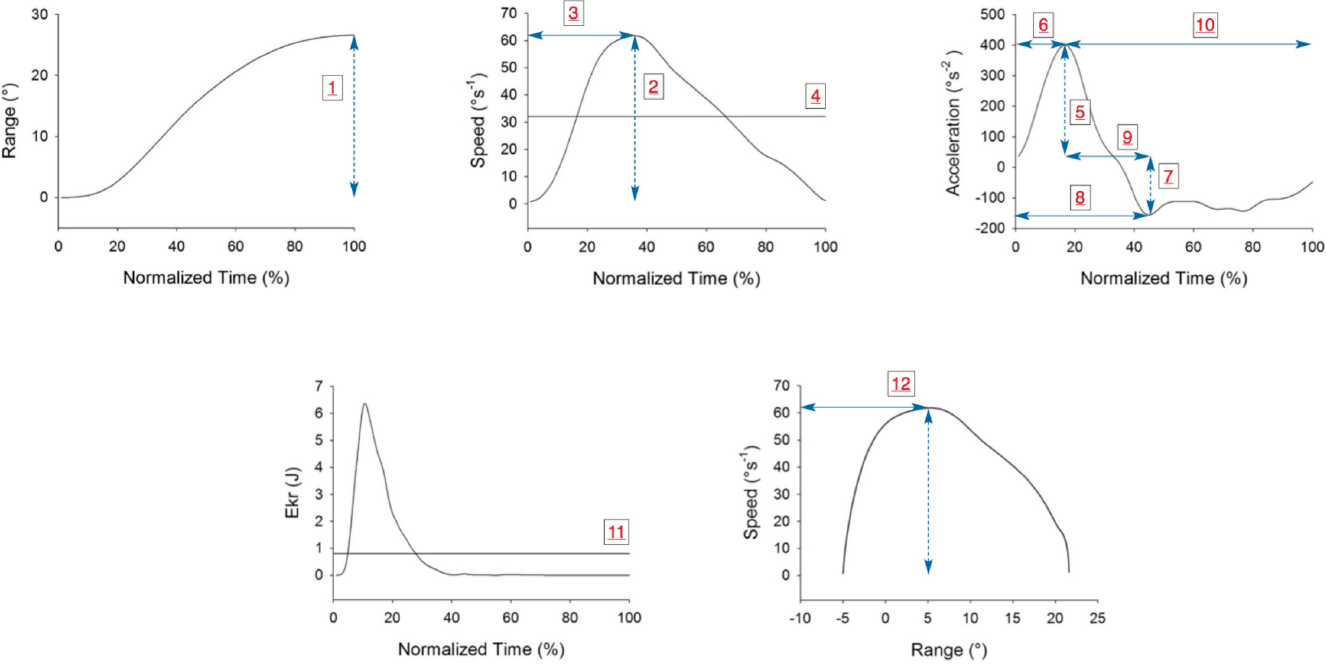
Fig 4. Typical plots of variables analyzed during one right rotation in a participant of the Younger adult’s group (age: 22 yrs, sex: female). All values are in absolute value. (1) range of motion (˚); (2) peak speed (˚ s -1 ); (3) time to peak speed (s); (4) average speed (˚ s -1 ); (5) peak acceleration (˚ s -2 ); (6) time to peak acceleration (time to achieve the peak of acceleration (s); (7) peak deceleration (˚ s -2 ); (8) time to peak deceleration (s); (9) time between peaks acceleration and deceleration (s); (10) time from peak acceleration to end of rotation (s); (11) Average rotational kinetic energy (J); (12) value of the angle when maximum speed is achieved